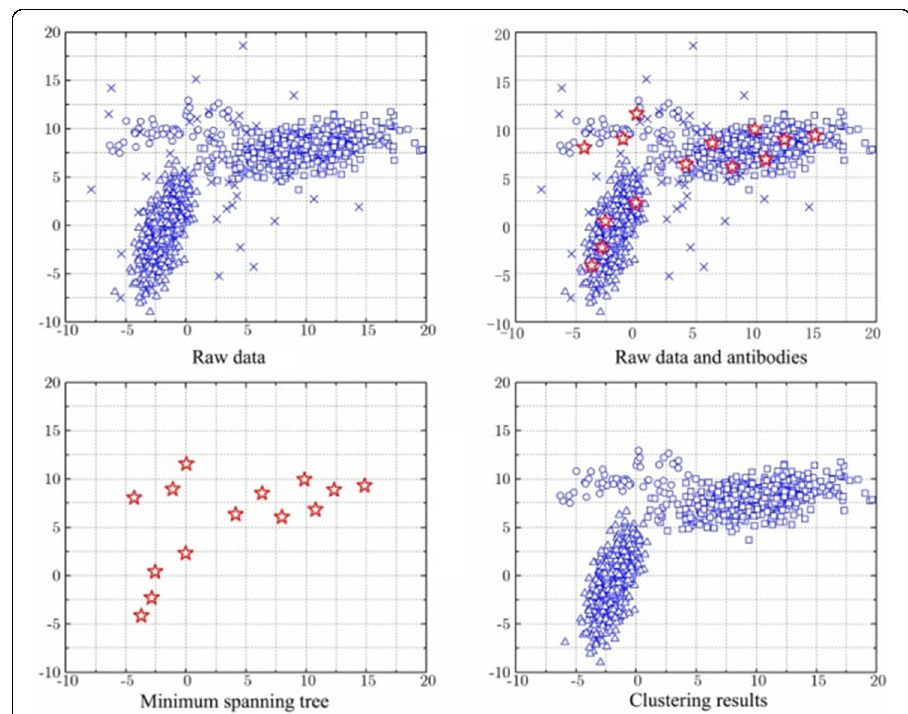
Fig. 2 Clustering effect on a synthetic